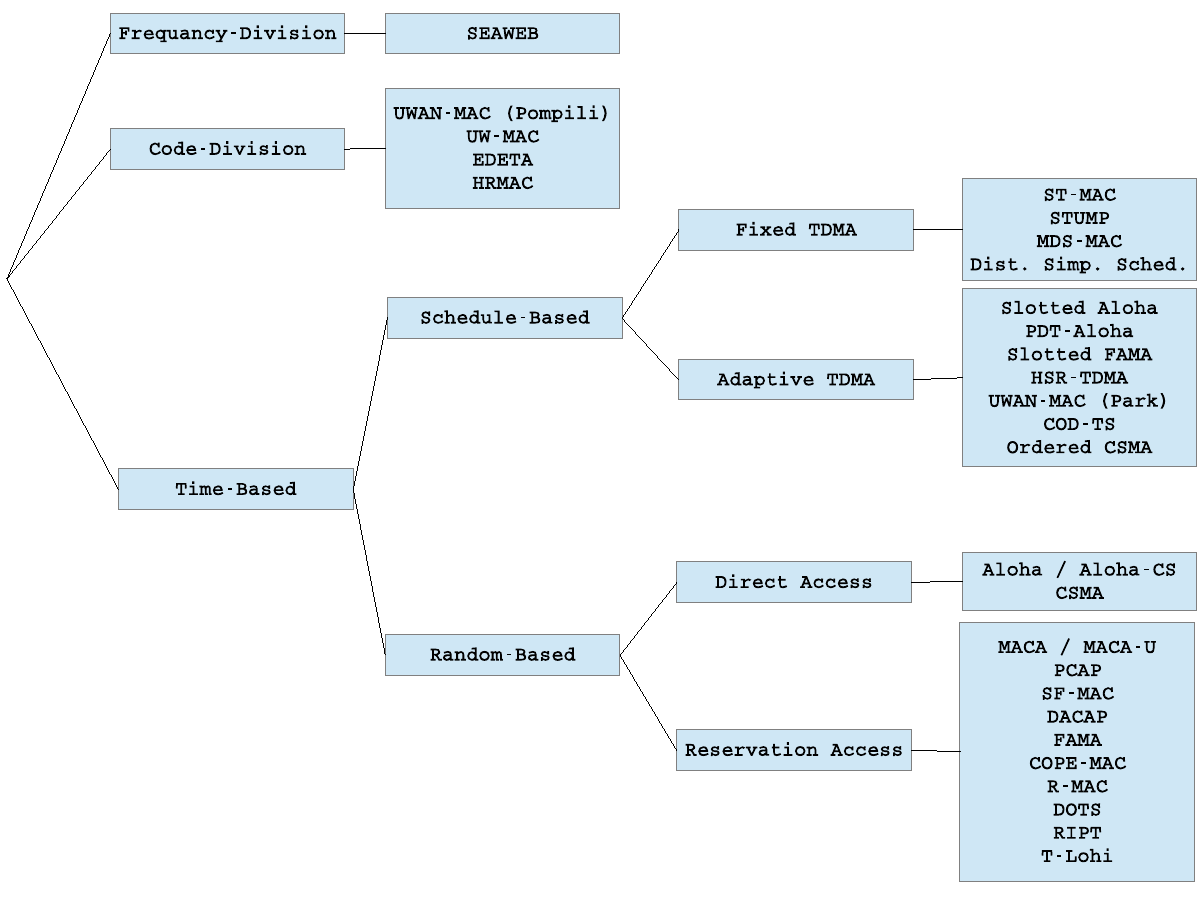
Figure 5. Classification of medium access control (MAC)